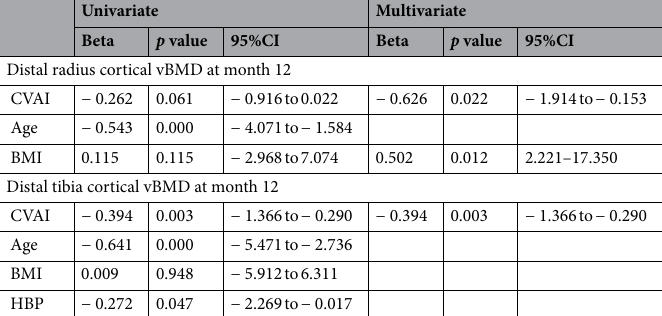
Table 3. The association between baseline CVAI and bone microstructure at month 12 in female ERA. vBMD: volumetric bone mineral density; CI: confidence interval; CAVI: Chinese adiposity visceral index; BMI: body mass index; HBP: hypertension; ERA: early rheumatoid arthritis.